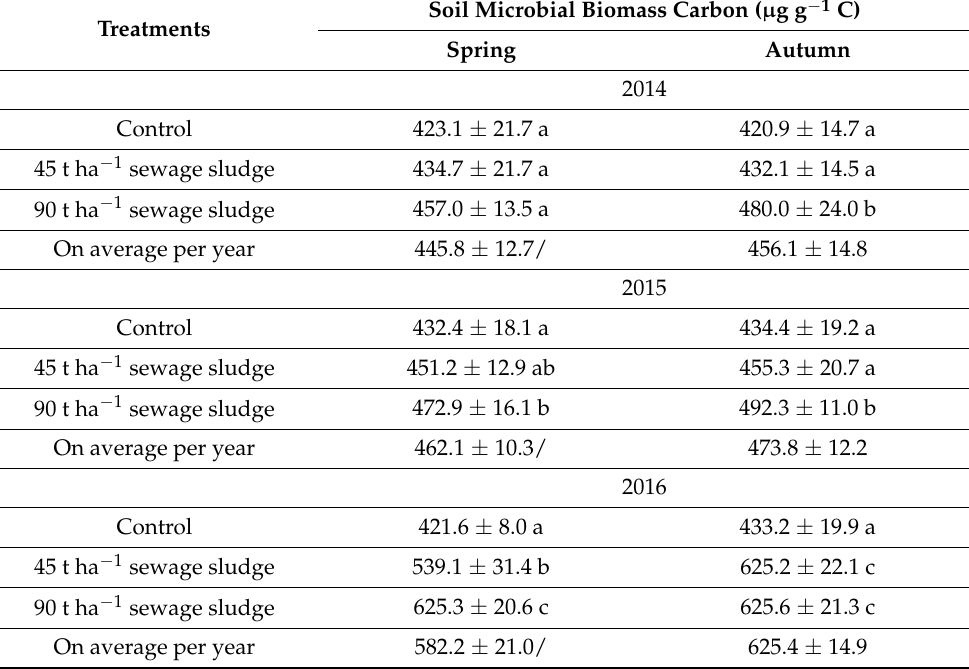
Table 5. The changes in soil microbial biomass carbon ( µ g g − 1 C) in humus horizon (0–30 cm depth) at the common osier’s site from 2014 to